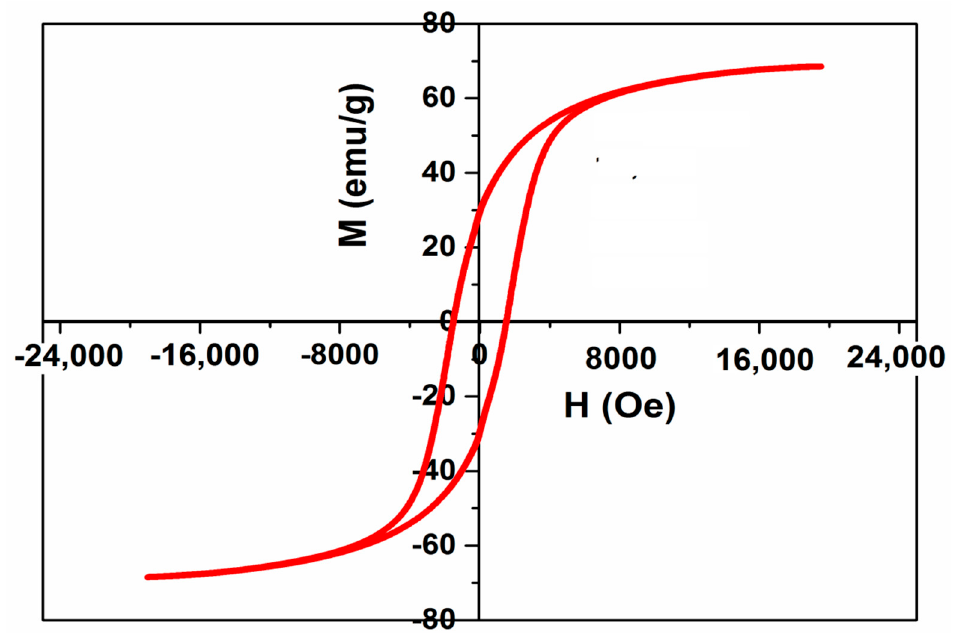
Figure 3. Hysteresis loop of CoFe 2 O 4 sample.